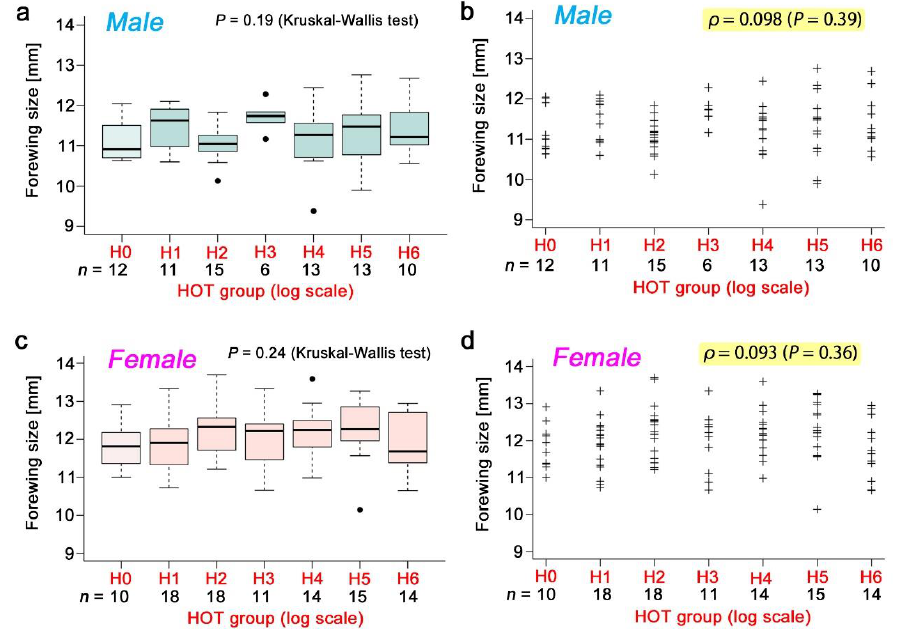
Figure 7. Forewing size of the individuals who consumed radioactive caesium chloride. In a and c, box plots were made, and the differences among groups were examined using a Kruskal–Wallis test. In b and d, individual sample data were plotted, and a Spearman correlation analysis was performed.